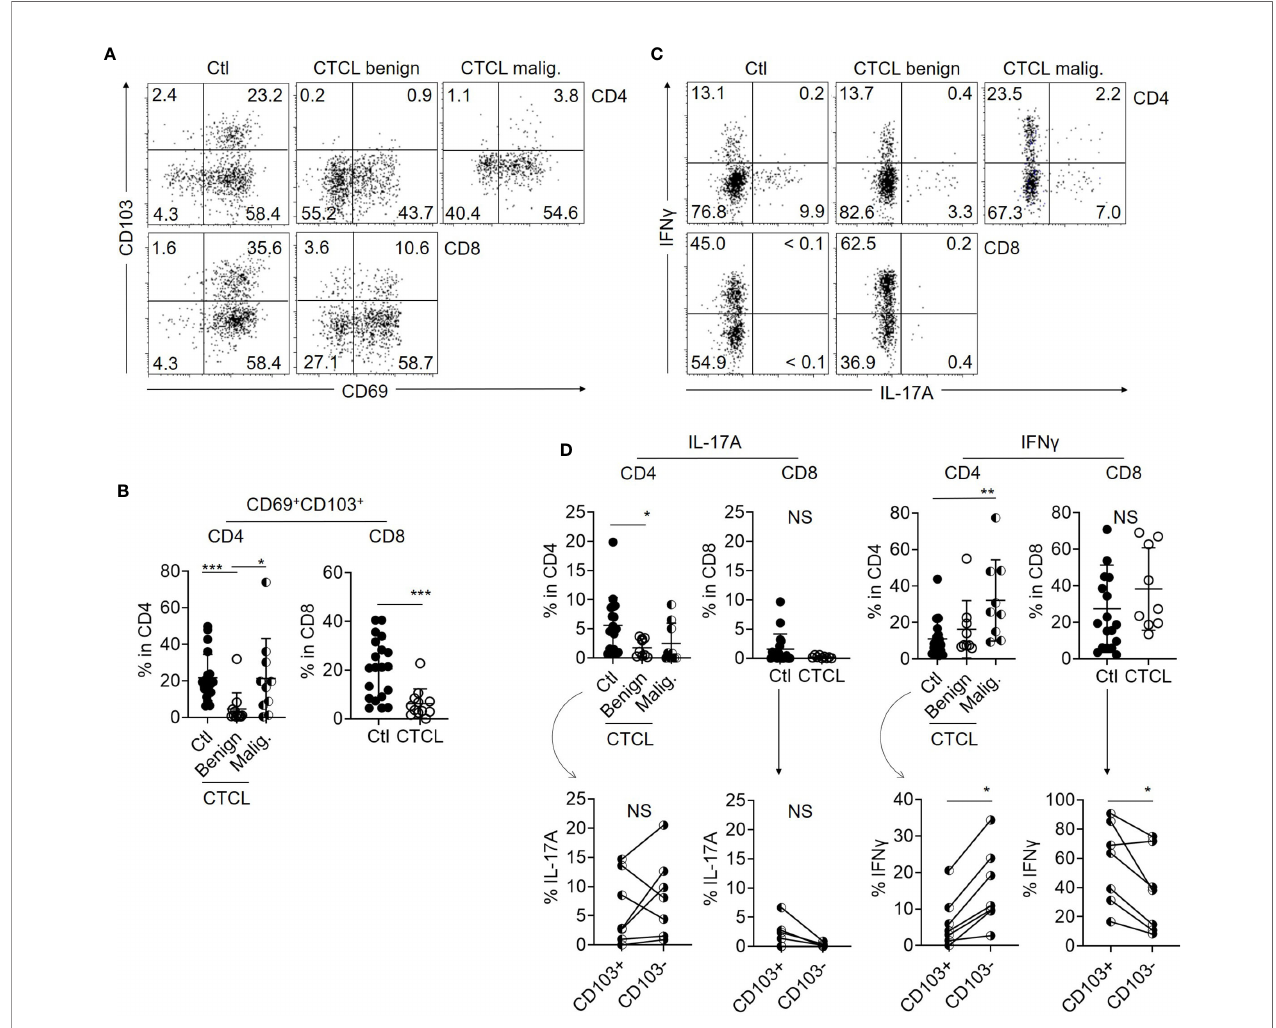
FIGURE 1 | Benign T cells in CTCL lesions include less T RM with limited Th17 property than those in control skin. (A) Representative dot plots showing the expression of CD69 and CD103 in CD4 and CD8 T cells from control skin specimens (Ctl), benign fraction, and malignant (malig.) fraction of CTCL lesions. (B) Graphs of the accumulated data showing the ratio of CD69 + CD103 + cells in CD4 and CD8 T cells from Ctl, CTCL benign fraction, and malignant fraction. N = 20 in Ctl, n = 12 in CTCL benign, and n = 10 in CTCL malig. (C) Representative dot plots showing the production levels of IL-17A and IFN g in CD4 and CD8 T cells from Ctl, CTCL benign fraction, and CTCL malignant fraction. (D) Top: Graphs of the accumulated data showing the production ratio of IL-17A and IFN g in CD4 and CD8 T cells from Ctl, CTCL benign fraction, and CTCL malignant fraction. N = 14 in Ctl, n = 9 in CTCL. Bottom: In the Ctl CD4 and CD8 cells, the production ratio of IFN g and IL-17A was compared between CD103 + and CD103 - fractions when the cytokines and CD103 were analyzed together. N = 7. * p < 0.05, ** p < 0.01, *** p < 0.001. NS, not signi fi